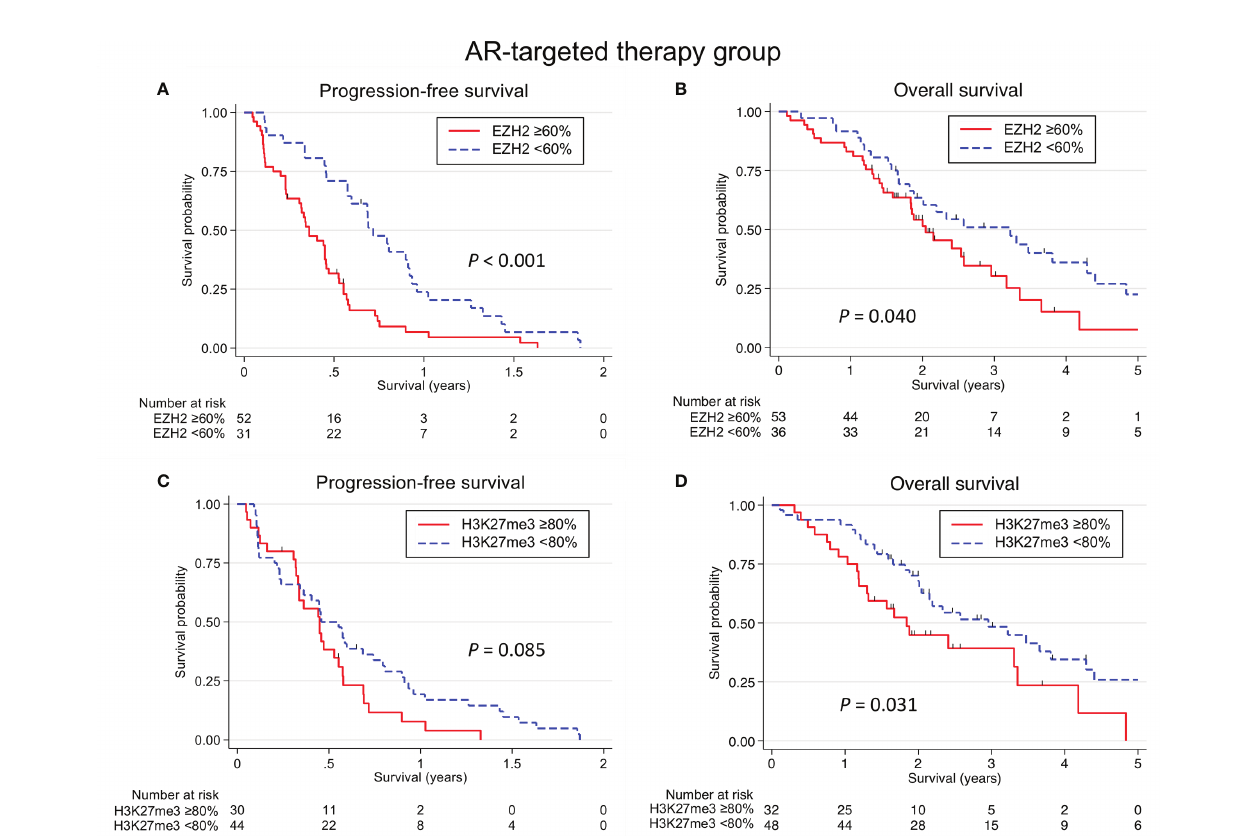
FIGURE 4 | Kaplan-Meier survival curves according to the EZH2/H3K27me3 expression in salivary duct carcinoma treated with AR-targeted therapy. An EZH2-high status was associated with a signi fi cantly shorter progression-free survival (PFS) (A) and overall survival (OS) (B) ( P < 0.001 and P = 0.040, respectively). (C) There was no signi fi cant association between the H3K27me3 expression and the PFS. (D) An H3K27me3-high status was associated with a shorter OS ( P =